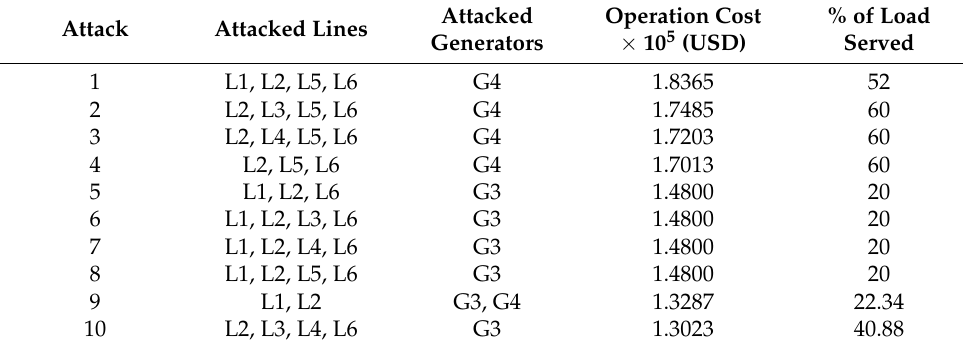
Table 5. Best attack plans.